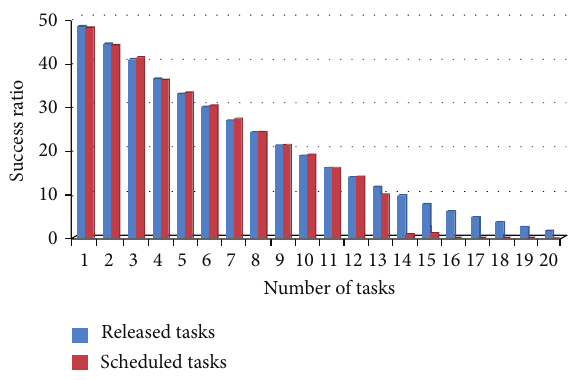
Figure 9: Success ratio of global scheduling for the system load of 2.94.